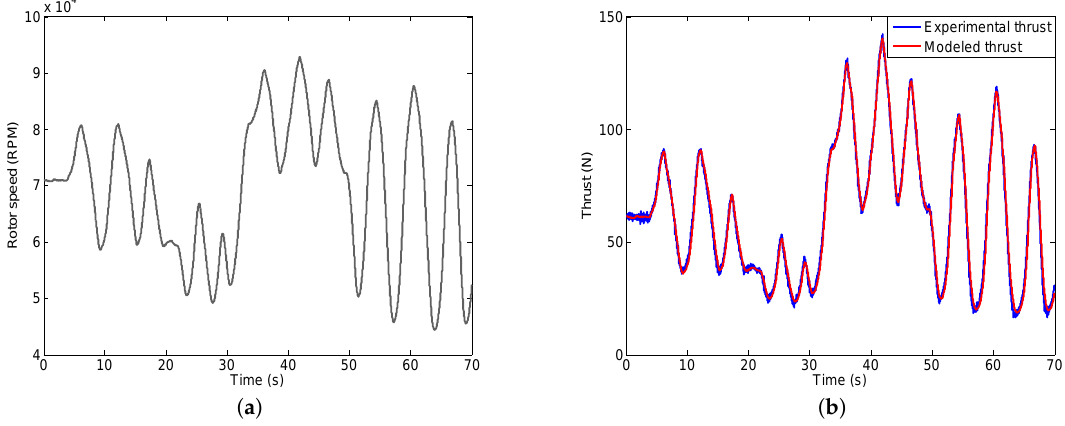
Figure 8. Thrust model validation using time-varying rotor speed. ( a ) Time-varying rotor speed; ( b ) Measured thrust and modeled thrust for time-varying rotor